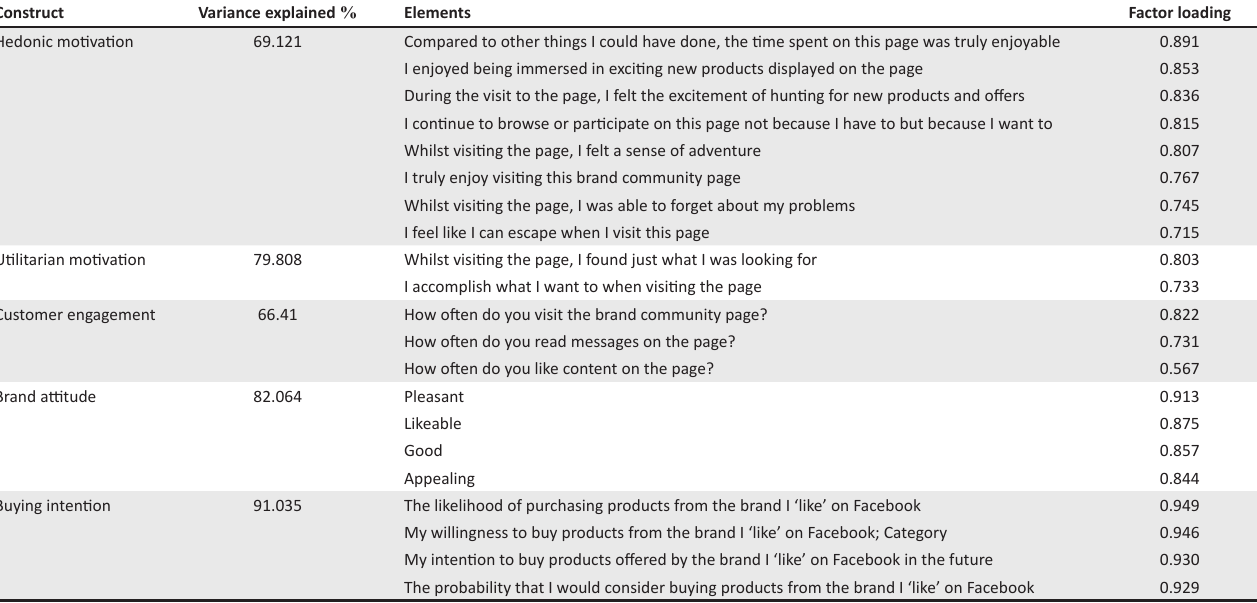
TABLE 3: Factor loadings.